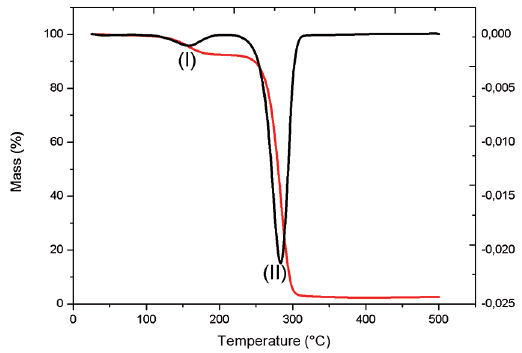
Figure 8: TGA and DTG curves of PHB plasticized with 10% glycerol. Heating rate: 10°C.min -1 under nitrogen atmosphere flow of 50 mL.min